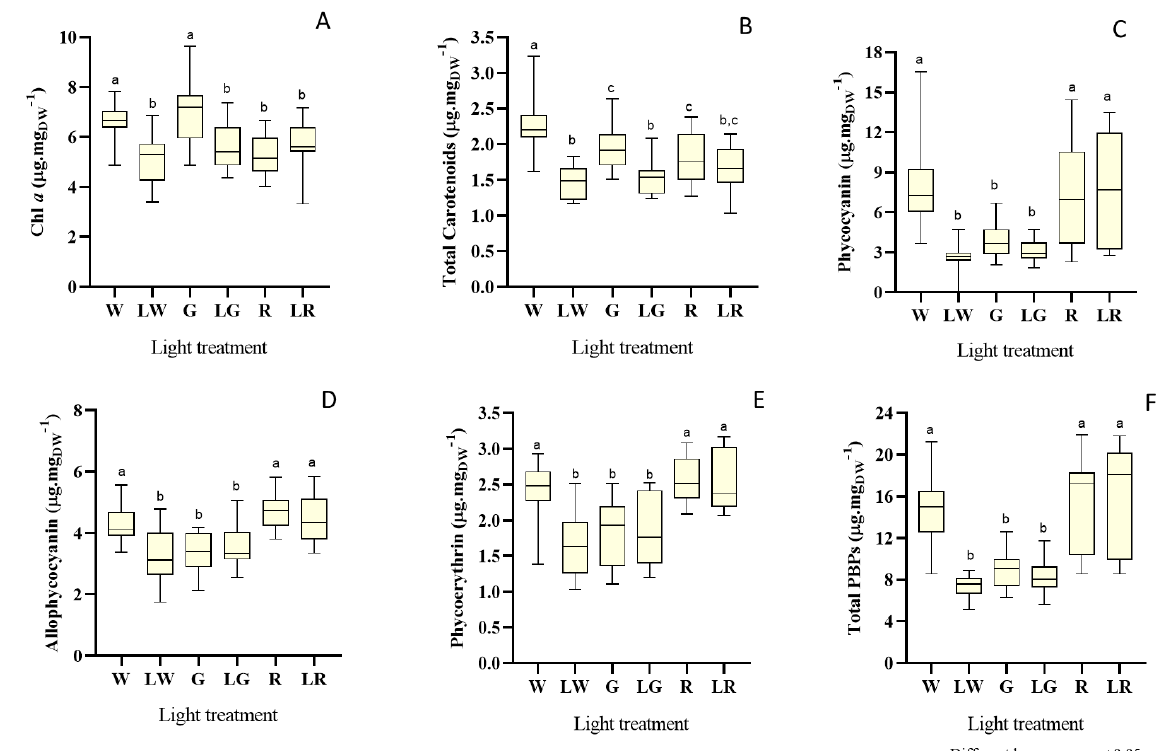
Figure 5. Box and whisker plots of pigment content, expressed in mg g DW − 1 , for each light treatment: W (white, 150 µ mol photons · m − 2 · s − 1 ) (control), LW (low white, 50 µ mol photons · m − 2 · s − 1 ), G (green, 150 µ mol photons · m − 2 · s − 1 ), LW (low green, 50 µ mol photons · m − 2 · s − 1 ), R (red, 150 µ mol photons .m − 2 .s − 1 ), and LR (low red, 50 µ mol photons · m − 2 · s − 1 ) applied to S. salina LEGE 06155, considering chl a ( A ), total carotenoids ( B ), phycocyanin ( C ), allophycocyanin ( D ), phycoerythrin ( E ), and to- tal phycobiliproteins ( F ). The horizontal line within the box indicates the median, the boundaries of the box indicate the 25th and 75th quartiles, and the whiskers indicate the lowest and the highest values of the results. The lowercase letters denote statistically significant differences ( p <